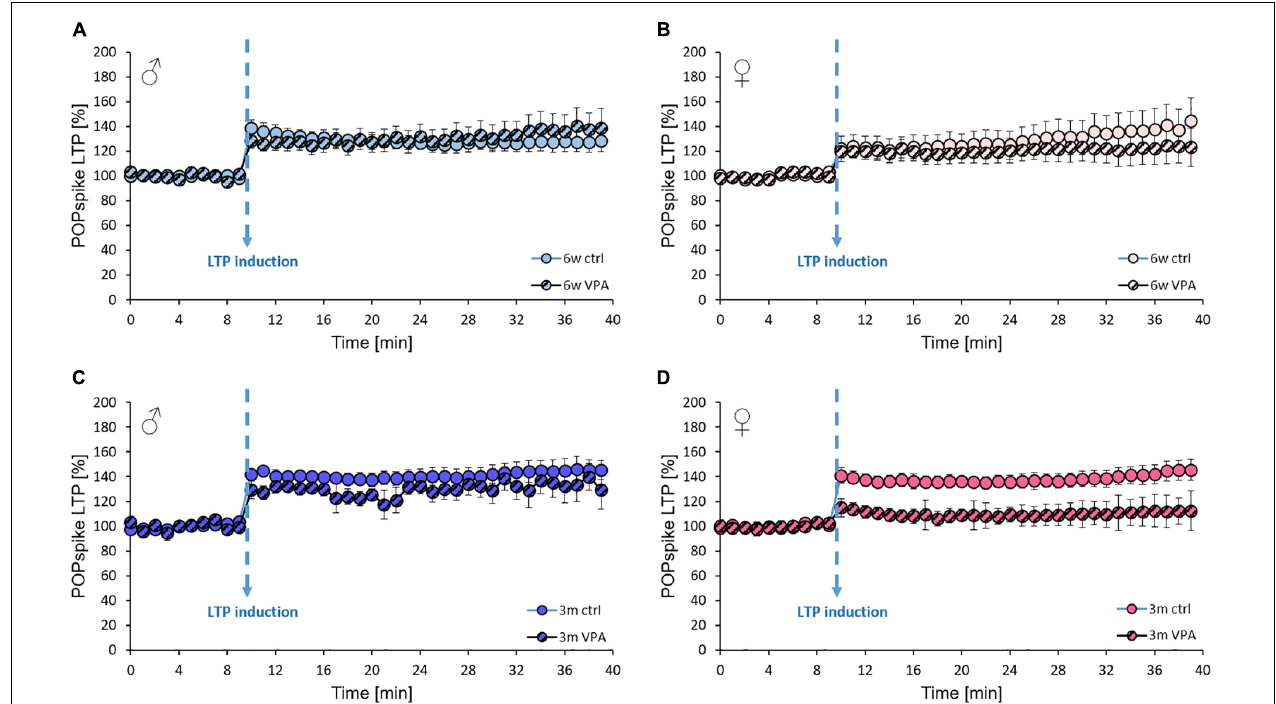
FIGURE 6 | The effects of prenatal VPA-treatment on the LTP of hippocampal neuronal networks in 6-week-old and 3-month-old rats of both sexes. (A) The average change in POPspike amplitude expressed as % of the 10-min baseline (time points were taken as an average of 6 data points) in control and VPA-treated 6-week-old males and (B) females and (C) in 3-month-old males and (D) females. Arrow indicates the time point of theta burst stimulation (TBS). LTP induction was followed for 30 min after TBS. Data are expressed as mean and S.E.M. Statistical analysis: repeated-measures